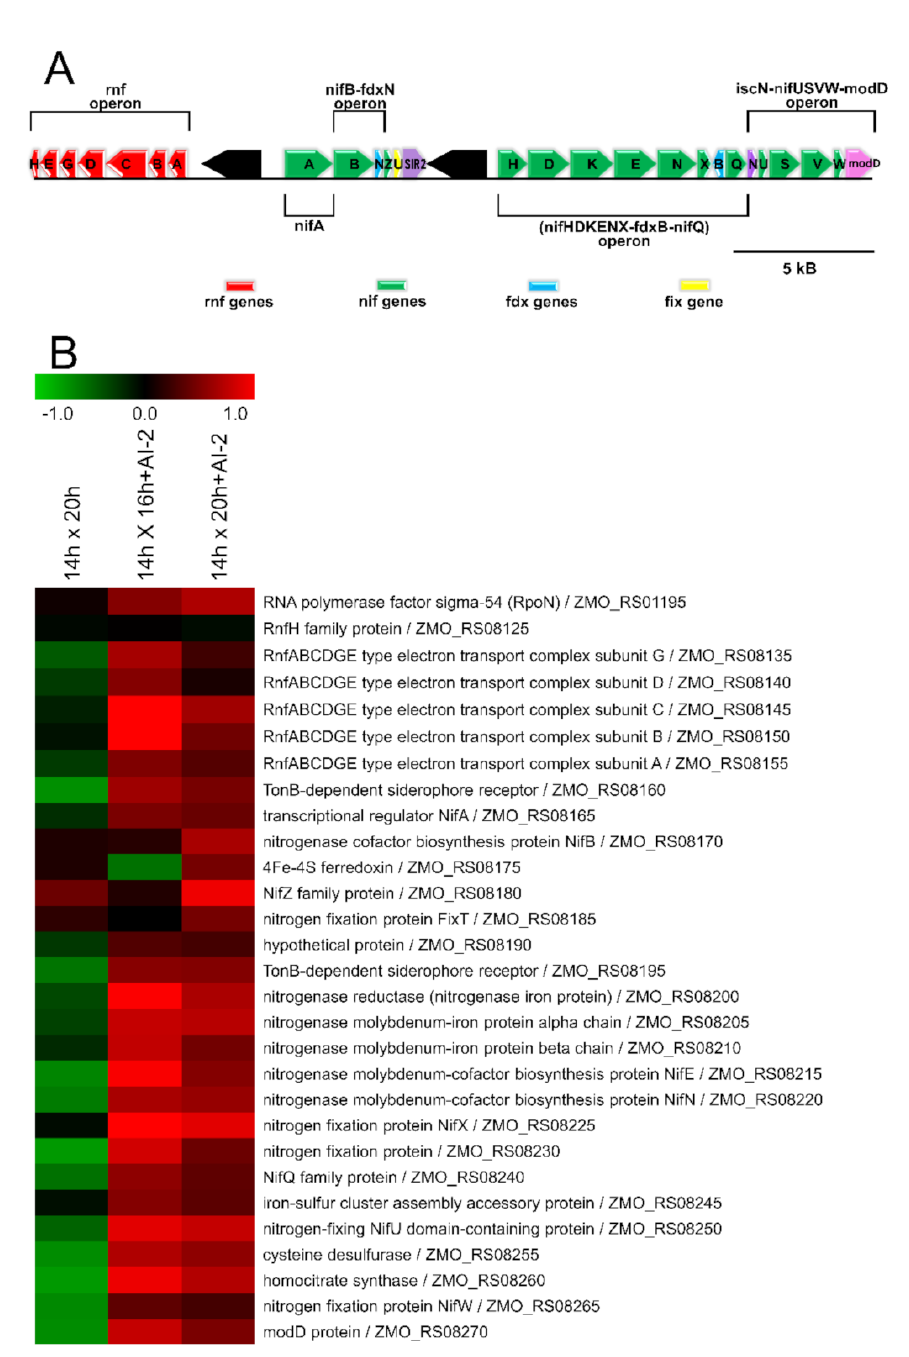
Figure 4. Transcriptional profile of genes responsible for N 2 fixation in Z. mobilis , in response to AI-2. The upper panel ( A ) shows the N 2 fixation locus present in the Z. mobilis chromosome. This locus consists of four operons, which contain genes directly involved in the production/maturation of nitrogenase, as well as those encoding electron donors, involved in the N 2 fixation process. The bottom panel ( B ) shows the expression pattern of the genes contained in this locus, in the presence or absence of AI-2, according to our RNA-seq data. The top element in panel B shows the expression profile of gene ZMO_RS01195, which is located outside the N 2 fixation locus shown in panel A. This element encodes an RpoN-like sigma factor (Sigma 54), supposedly involved in transcription of N 2 -fixation genes, which is also upregulated in response to